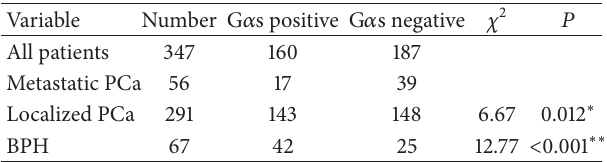
Table 2: Characterization of the cohort of 347 prostate cancer